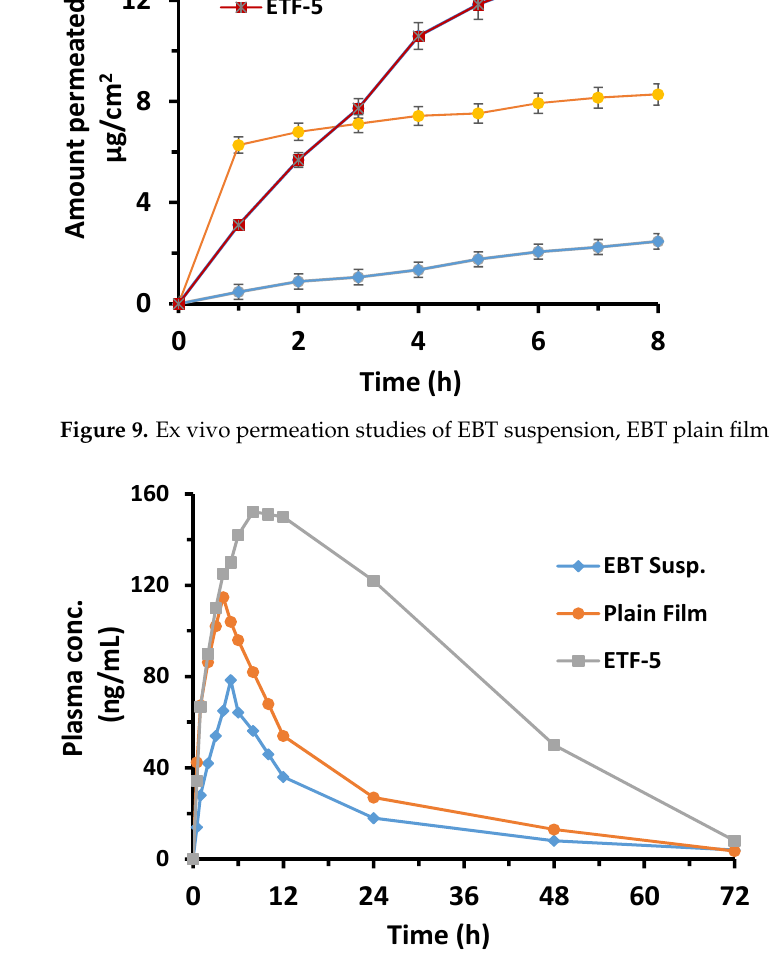
Table 4. Summary of in vivo pharmacokinetic parameters of carebastine following the administration of EBT suspension, EBT plain film and EFT-5.